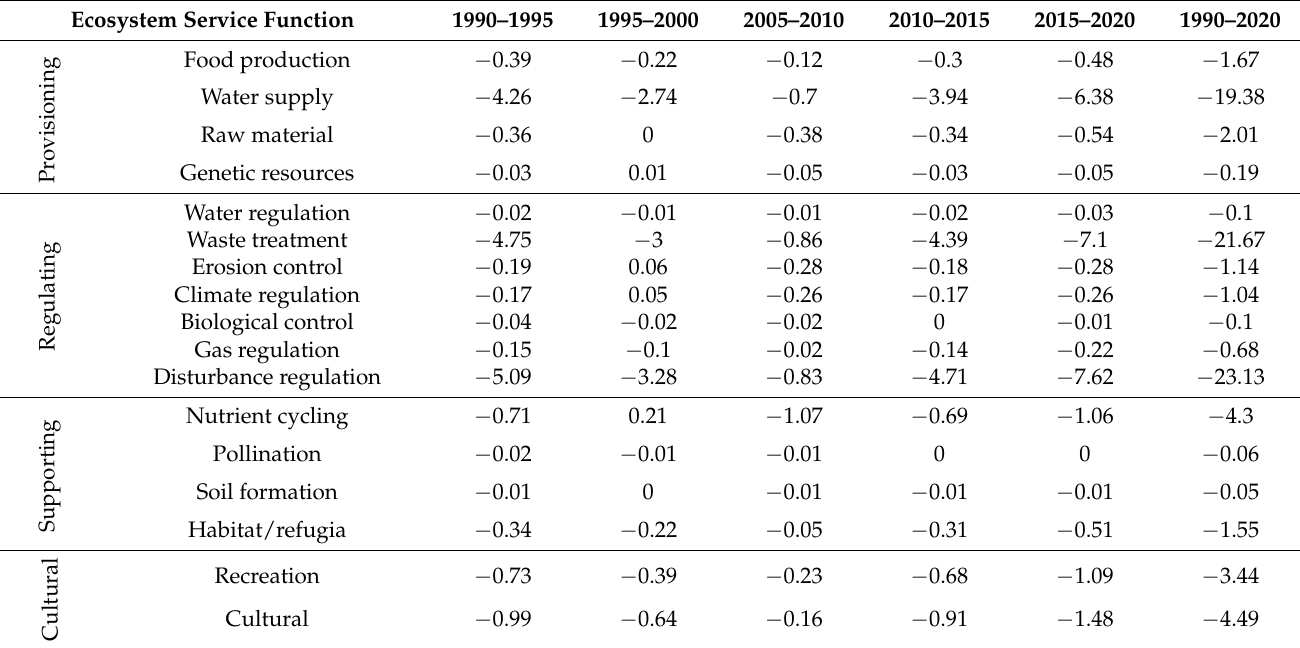
Soil formation − 0.01 Habitat/refugia